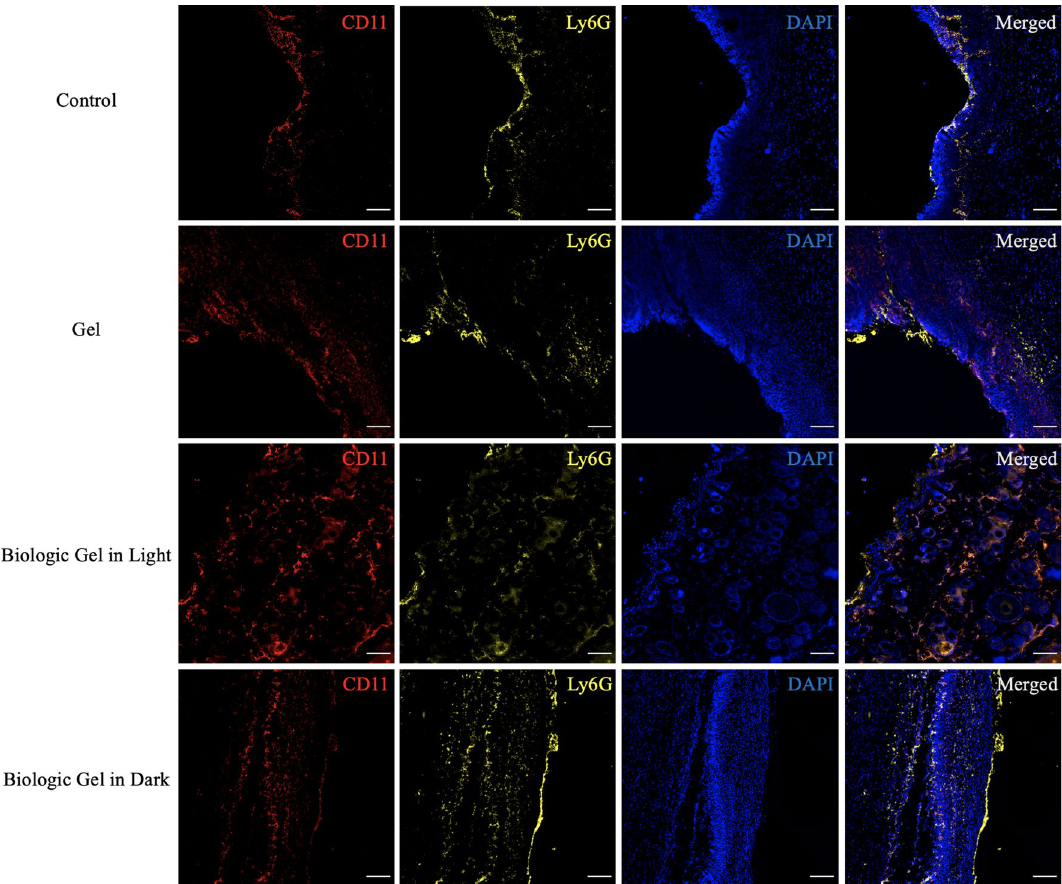
Figure 7. Immunohistochemical staining of local immune cells after 3 days of treatment in a rodent peripheral arterial disease ischemic wound model. Wounds that received the novel biologic gel in light treatment demonstrated the least amount of Lg6G+ cell infiltration in the dermis and subcutaneous tissue compared to wounds that received other treatments. CD11+ cell population remained similar among the four treatment groups. The control group received no treatment. Note that CD3+ split channel images are not shown here as very minimal signals were observed. Red = CD11, yellow = Ly6G, blue = DAPI. Scale bar = 100